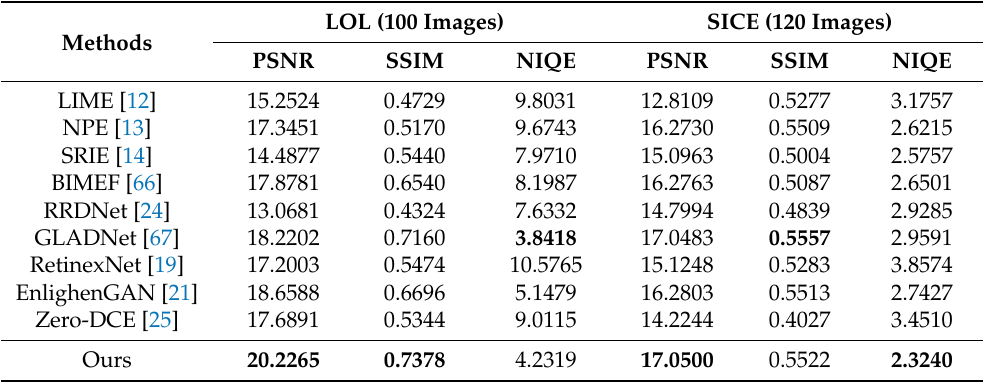
Table 1. Quantitative comparison between our method and other state-of-the-art methods on LOL dataset and SICE dataset. The best results are highlighted in